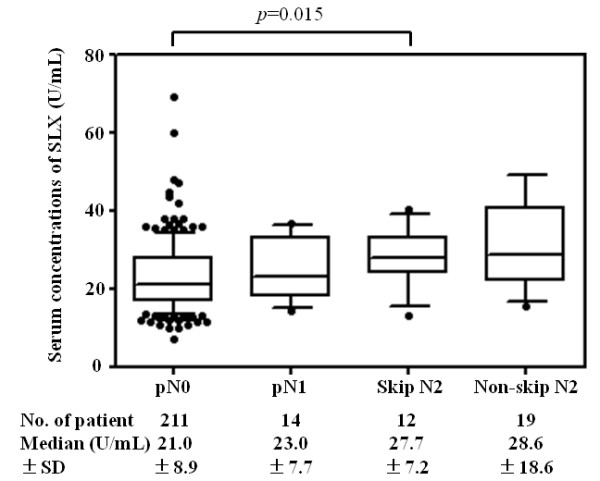
Percentile distribution of serum sialyl Lewis X (SLX) concentrations in pathological (p)N0, pN1, skip N2, and non-skip N2 patients with clinical stage IA non-small cell lung cancer (NSCLC). Each box contains the variable distribution between the 25th and 75th percentiles, with median value indicated with a line in the box. The bars extending above and below the box indicate the 90th and 10th percentiles, respectively. The mean SLX concentration was significantly higher in the skip N2 patients compared to that in the pN0 patients (P = 0.015).